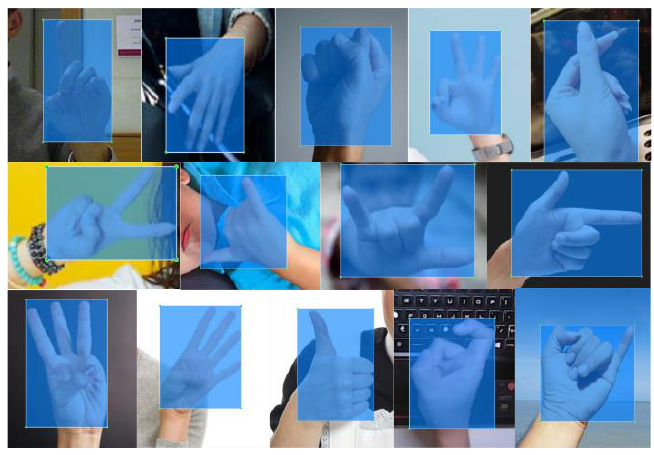
Figure 7. Gesture datasets.